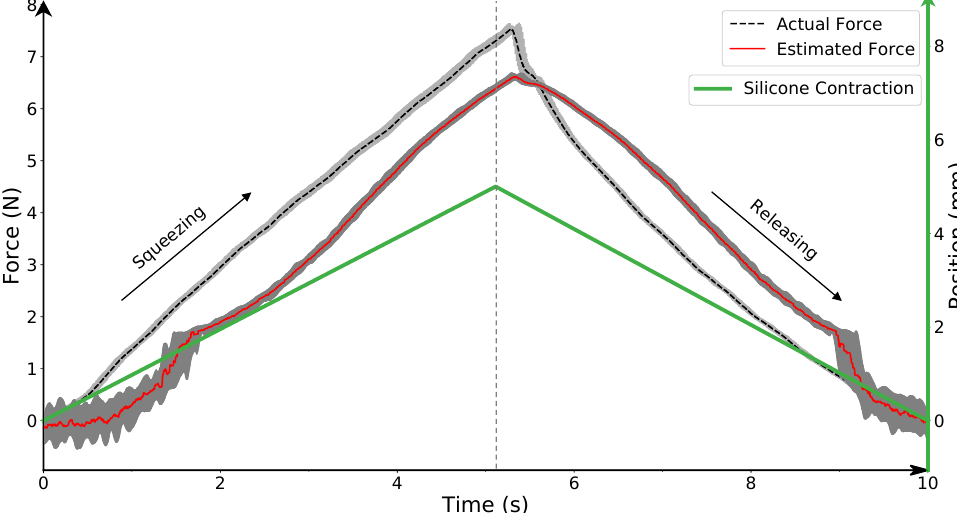
Figure 6. Comparative force sensing performance of the PhotoElasticFinger. Actual force is provided by an industrial force-torque sensor and compared with the estimated force provided by the proposed PhotoElasticFinger sensor. The gray areas represent the variance for 10 trials. Right-hand axis (green) represents the position of the gripper. Gripper speed = 1